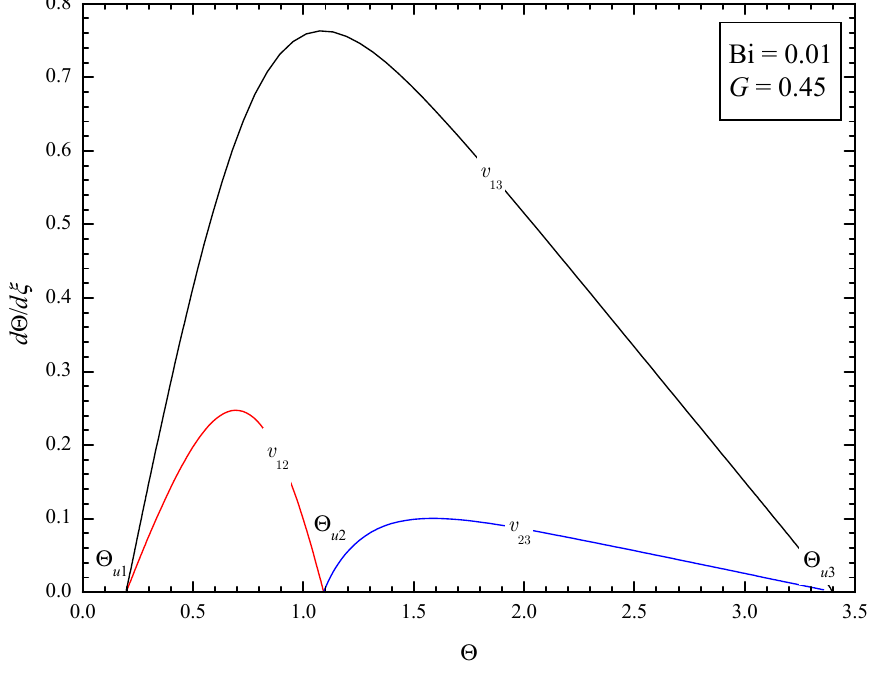
Figure 12. Monotonic wave fronts.